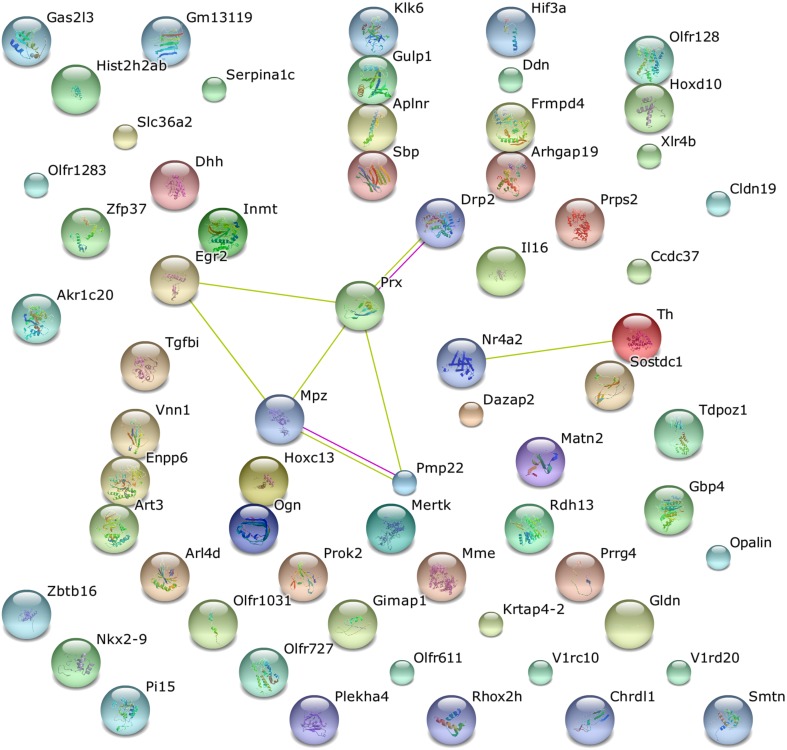
STRING analysis of pathway enrichment and interaction in the altered mRNAs of the MLC/SOD1G93A transgenic mice. Protein products of five modulated mRNAs (Drp2, Prx, Egr2, Mpz, and Pmp22) were involved in eight interactions.